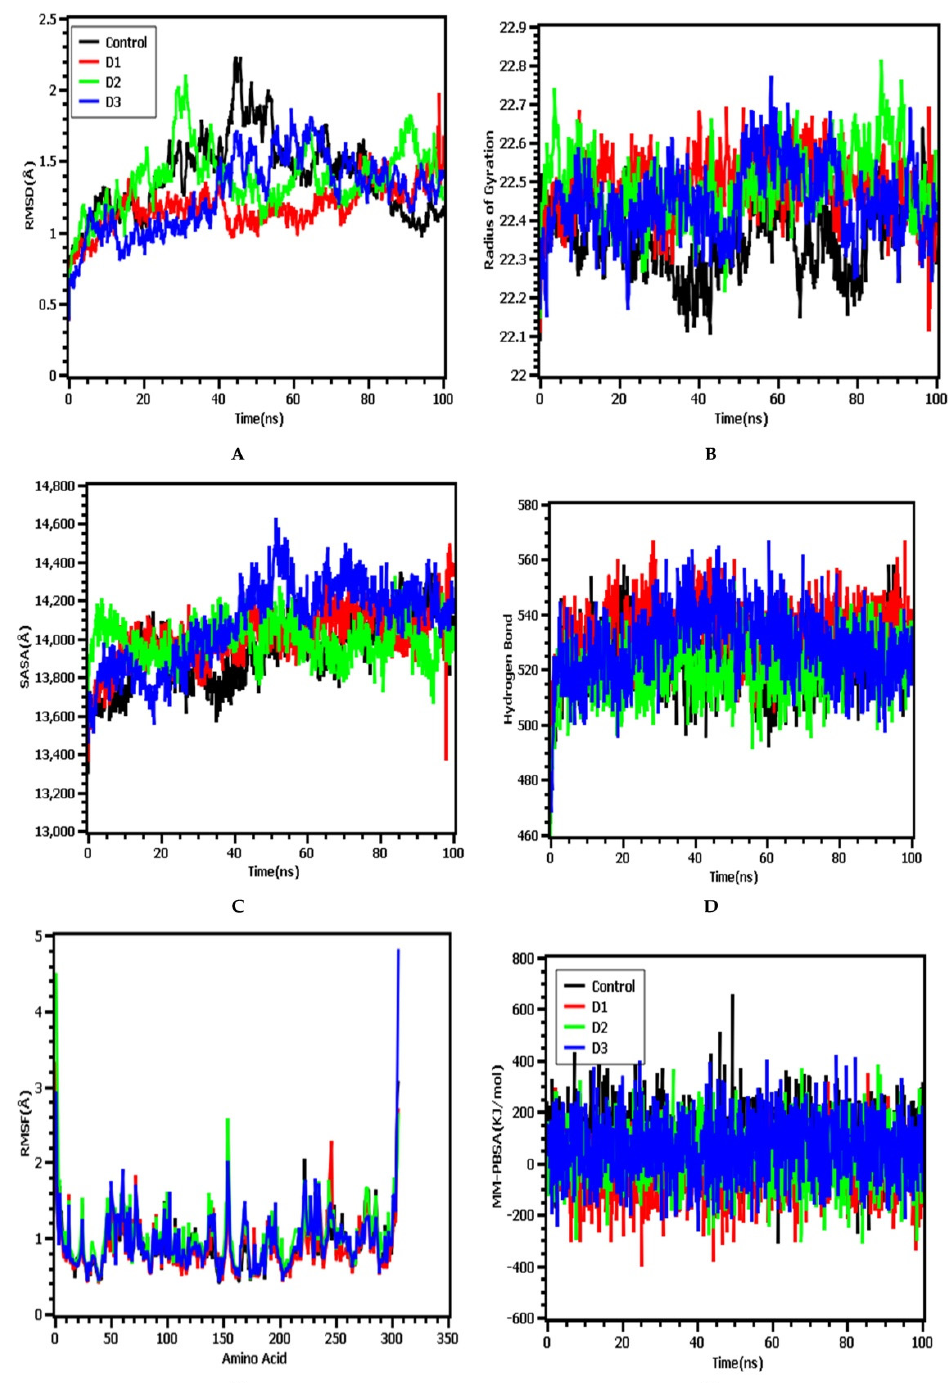
Figure 6. The molecular dynamics simulation of the four docked complexes. ( A – F ) Present, RMSD, Rg, SASA, hydrogen bonds, RMSF, and MM-PBSA analyses, respectively. Here, lorazepam, 11-oxa-dispiro[4.0.4.1]undecan-1-ol, azetidin-2-one-3, 3-dimethyl-4-(1-aminoethyl), and inhibitor N3 were denoted as D1, D2, D3, and control, respectively.